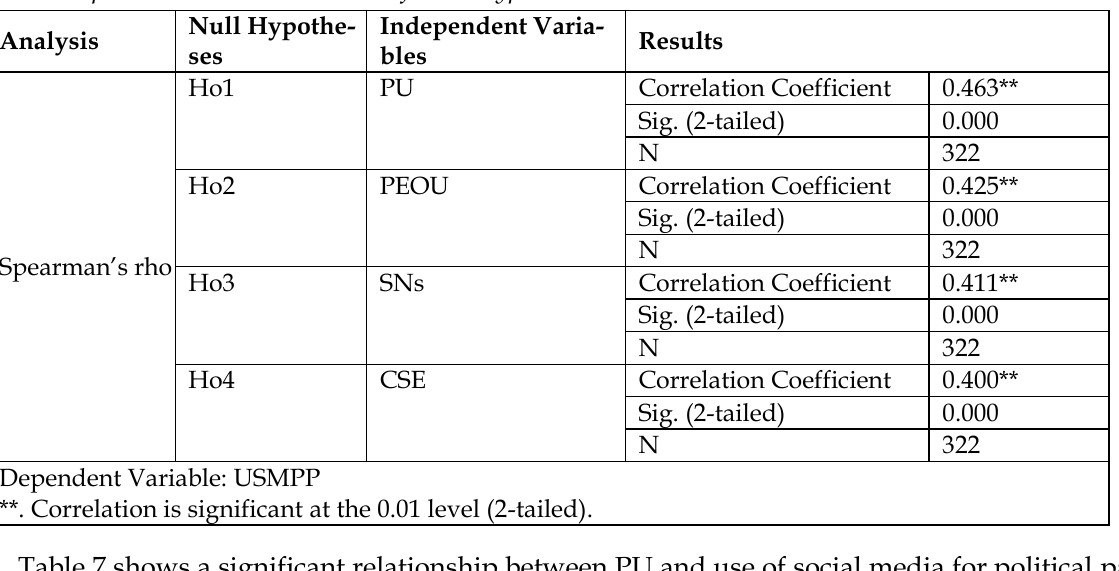
Table 7: Spearman correlation results for the hypotheses. Analysis